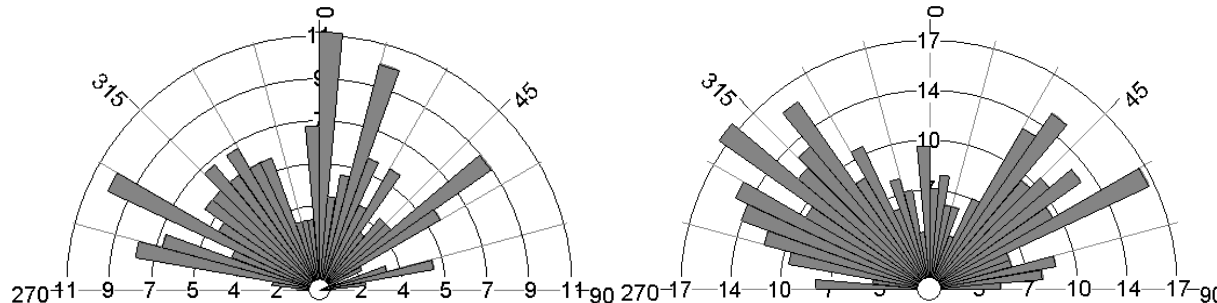
Fig. 6. Frequency-rose diagrams differentiating morphological lineaments to fluvial induced lineaments and lithological border induced lineaments (some lineaments are double-counted since they correspond to both characteristics).